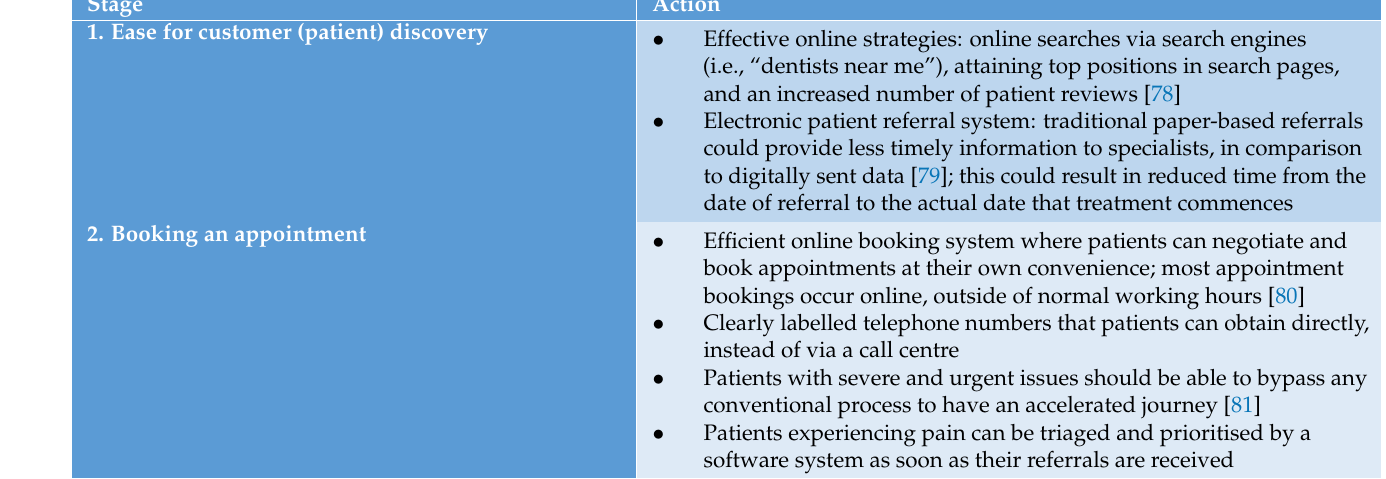
Table 3. Summarised digital transformation and omnichannel marketing recommendations to enhance the customer (patient)